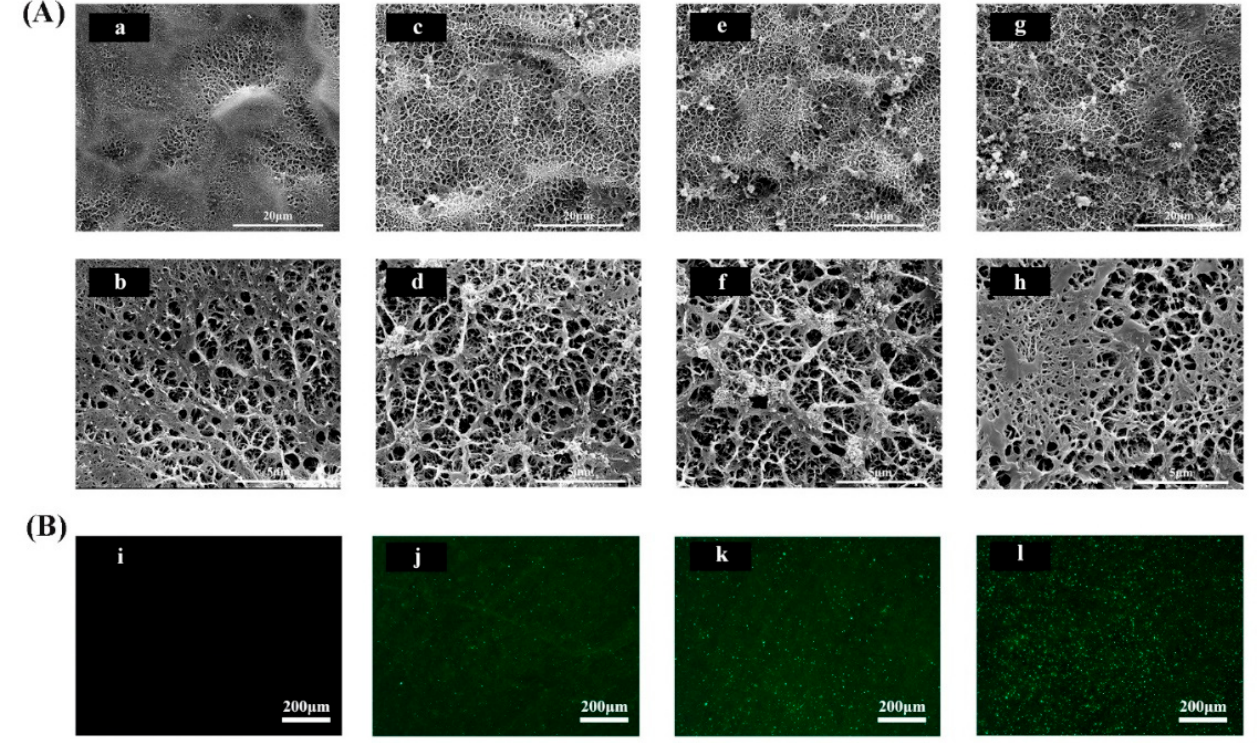
Figure 1. ( A ) SEM images of the calcium phosphate (CaP, a , b ), lactoferrin-low(LF-L, c , d ), lactoferrin- middle (LF-M, e , f ), and lactoferrin-high (LF-H, g , h ) surfaces; ( B ) fluorescein isothiocyanate labeled lactoferrin (FITC-LF) distribution on the CaP ( i ), LF-L ( j ), LF-M ( k ), and LF-H ( l ) surfaces.